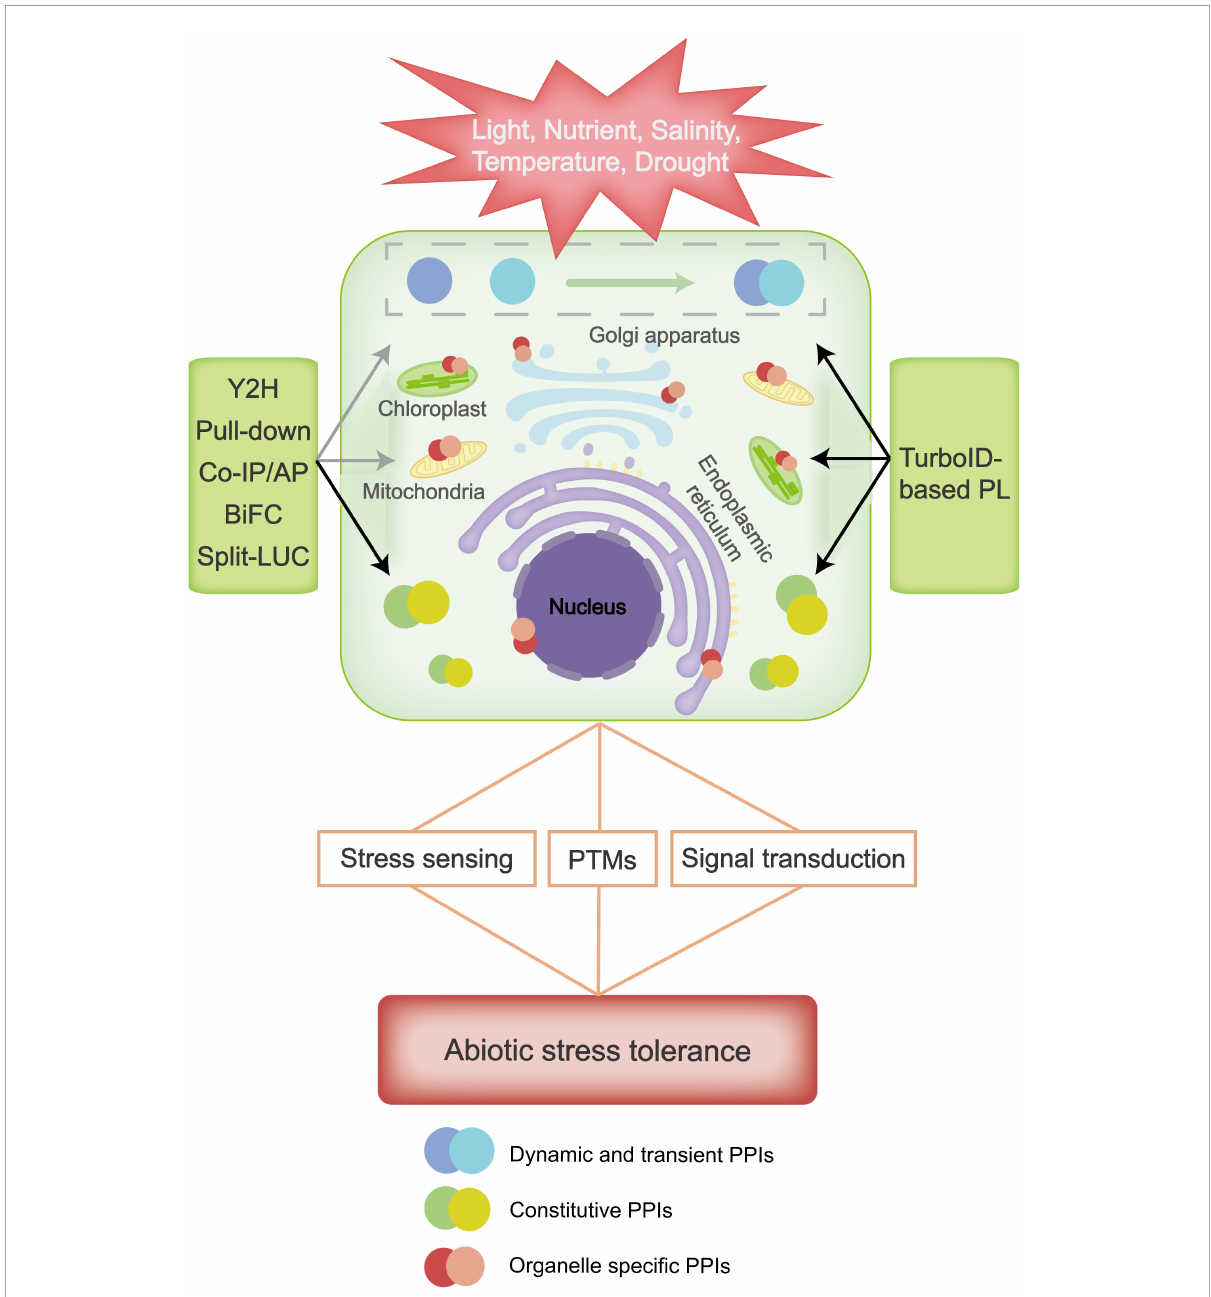
FIGURE1 Plant resistance to abiotic stresses involves stress sensing, signal transduction and post-translational modifications (PTMs) of proteins, etc., in which many protein-protein interactions (PPIs) are involved. Classic methods such as Yeast Two Hybrid (Y2H), Pull-down, Co-Immunoprecipitation (Co-IP), Affinity Purification (AP), Bimolecular Fluorescence Complementation (BiFC), and Split Luciferase (Split-LUC) can easily detect stable protein interactions, such as constitutive PPIs that are typically macromolecular complex, but they are difficult to detect dynamic and organelle specific interacting proteins in response to abiotic stress. TurboID-based proximity labeling (PL) has great advantages in detecting dynamic, transient and organelle specific interacting proteins, and can be applied to study regulative PPIs under abiotic stress. Black and gray arrows indicate high and low applicability of the classic and TurboID-based technique(s) in detecting the corresponding